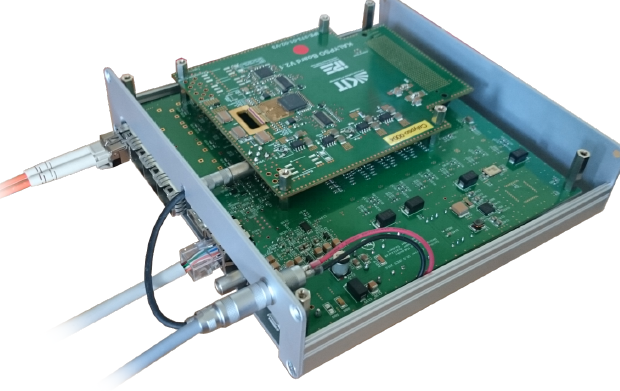
Figure 4. A photograph of the DAM module with a KALYPSO